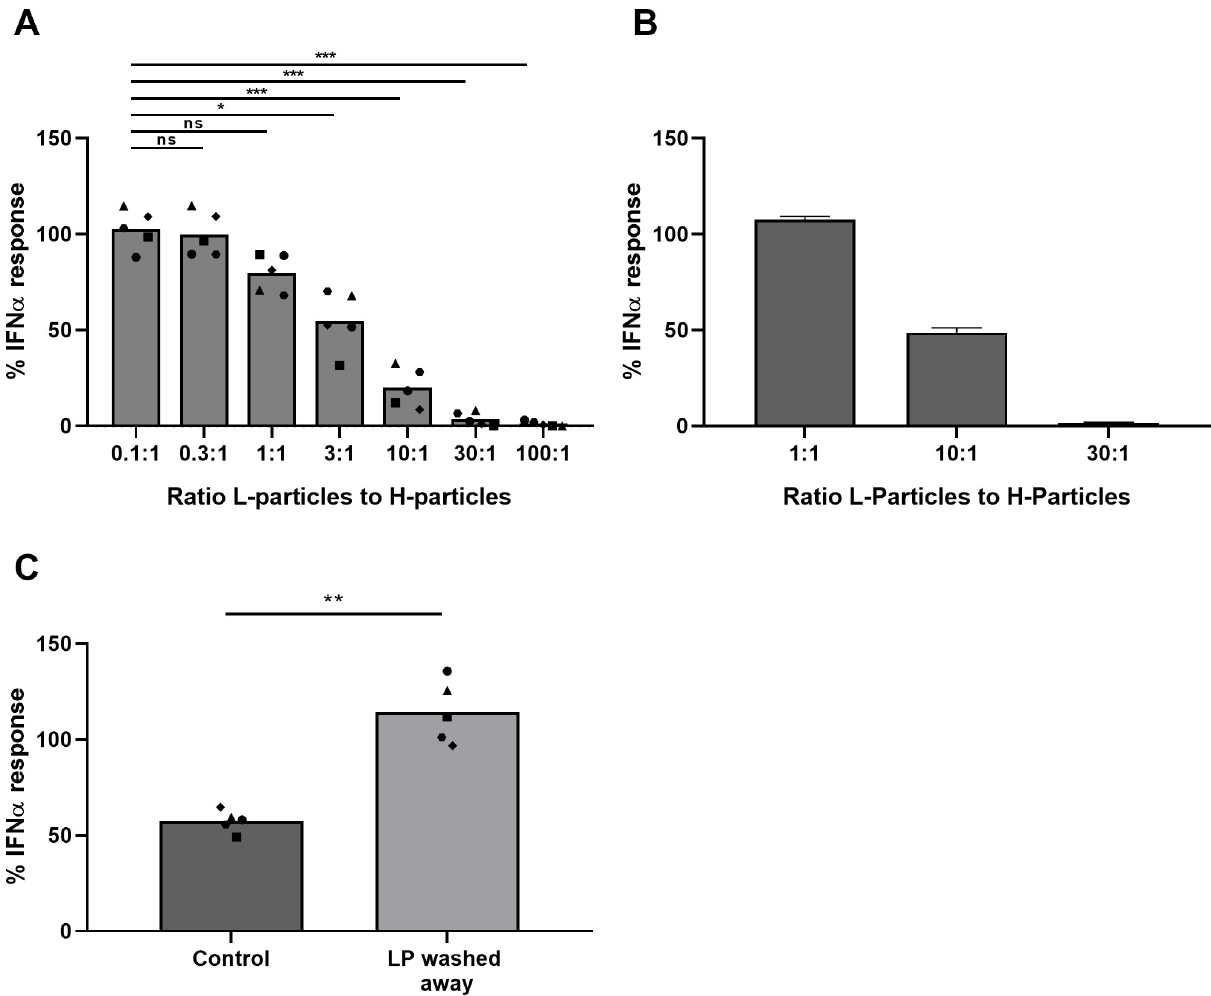
Fig 6. The L-particle mediated inhibition of the PRV H-particle-induced IFN α response by pDC is dose dependent. (A) Porcine PBMC were incubated for 22h with density gradient purified H-particles and different amounts of UL25null L-particles or a corresponding mock sample. IFN α levels were determined by ELISA. IFN α responses are normalized to the mock condition (set to 100) for each of the five independent repeats. (‘ns’ not significant, ‘ � ’ P < 0.05, ‘ ��� ’ P < 0.001). (B) FACS-purified porcine pDC were incubated for 22h with density gradient purified H-particles and different amounts of UL25null PRV L-particles or a corresponding mock sample (n = 1). The measured IFN α responses are normalized to the mock condition (set to 100) and error bars represent the standard deviation of two technical replicates. (C) Porcine PBMC were pre-incubated density purified UL25null L-particles or a corresponding mock sample for 2h at 37˚C, washed and subsequently medium containing H-particles with or without the same number of L-particles as during the pre-incubation (corresponding to a 5:1 ratio of L-to-H-particles) was added. Following 22h of incubation at 37˚C, supernatant was collected and IFN α concentrations were determined. IFN α responses are normalized to the mock condition (set to 100) for each of the five independent repeats. (‘ �� ’ P <